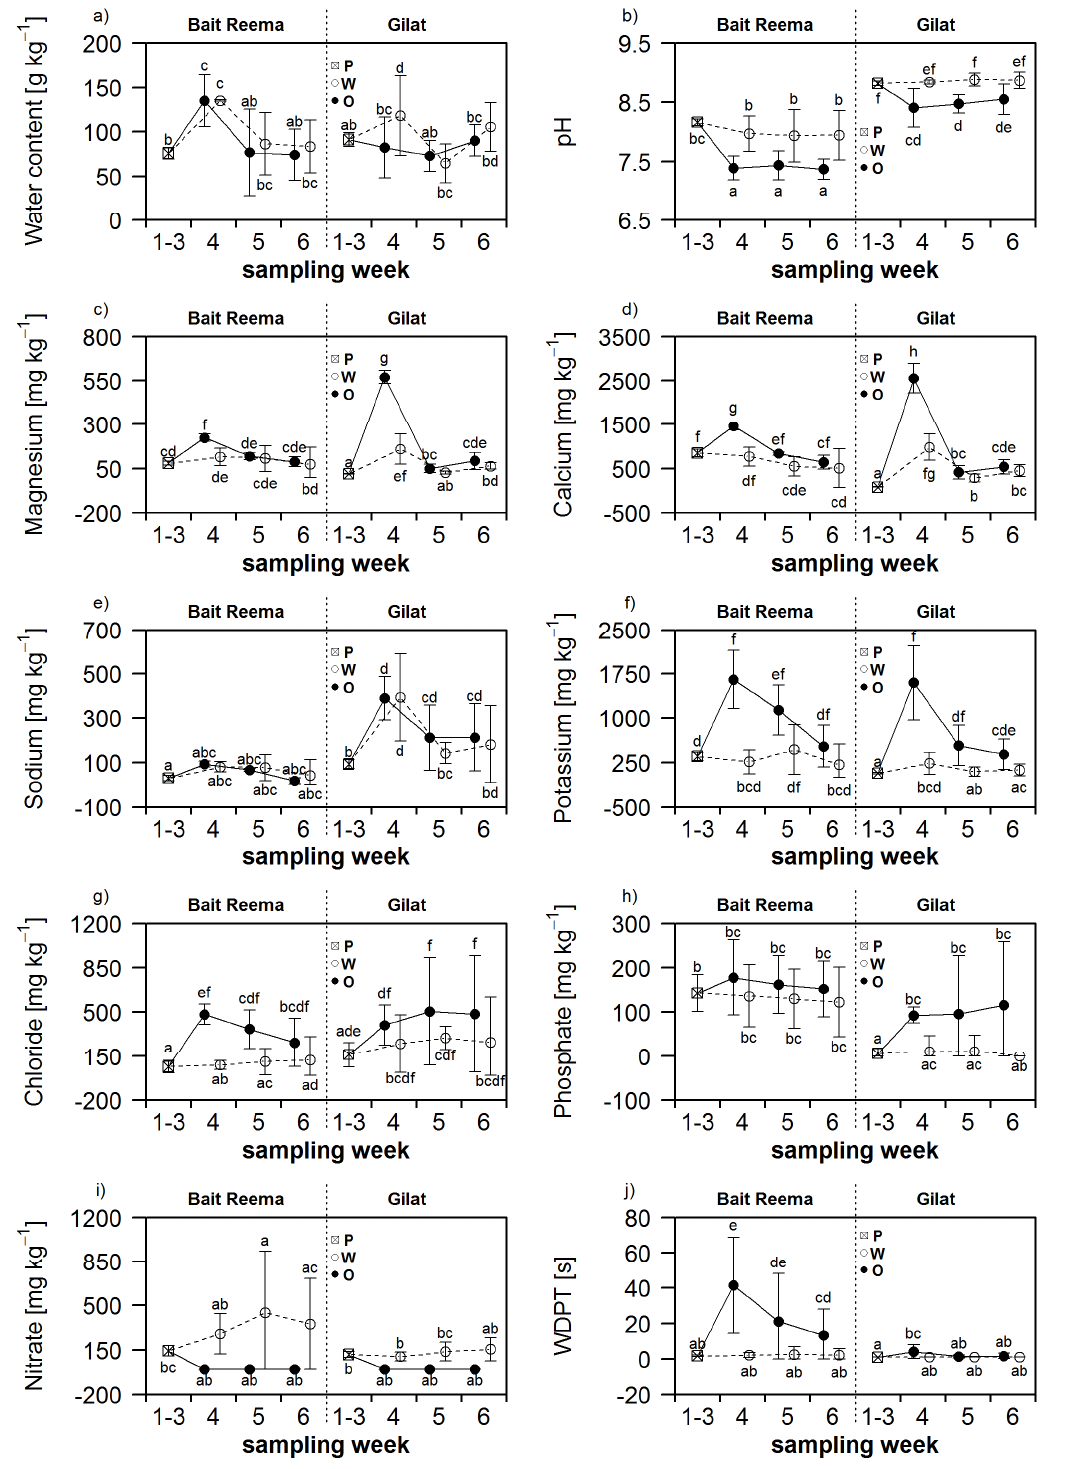
Figure 3. Evolution of water content, pH, concentration of nutrient cations as well as anions and chloride and wettability following amendment with OMW and water during six weeks of sampling in Bait Reema and Gilat. P, data before the application (were averaged after finding no statistical differences between three sampling weeks); W, water application; O, OMW application. Mean values followed by the same letter are not statistically different. Error bars show ±95 % confidence